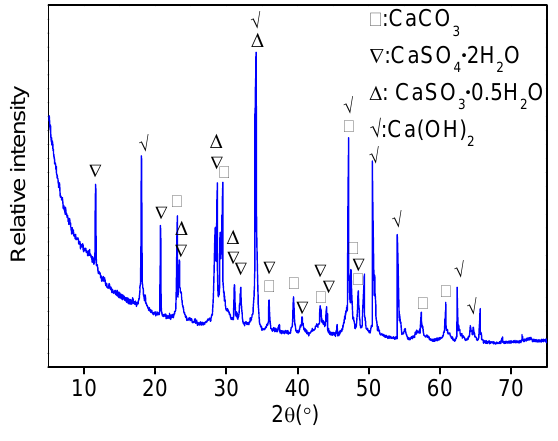
Figure 8. Mineral phases of DGR.